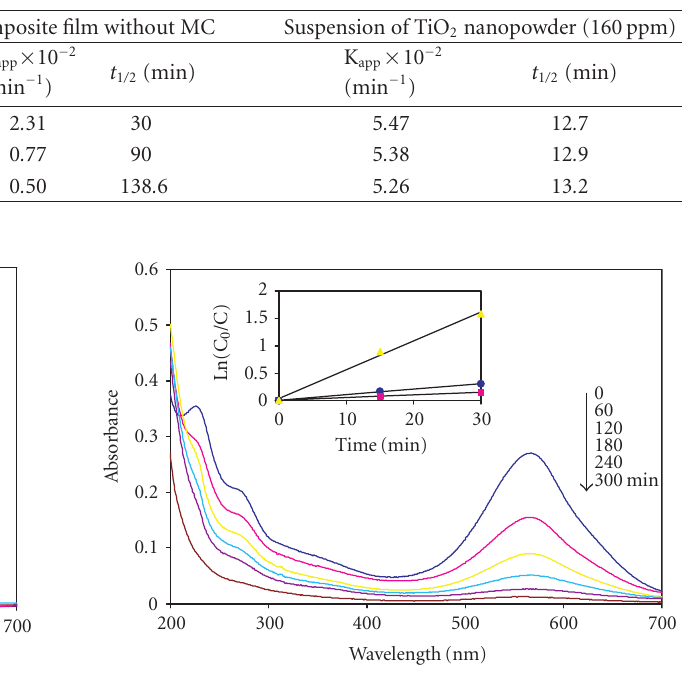
Figure 8: Time-dependent UV-Vis spectrum of Tertro direct light blue solution during photoirradation on one piece of composite TiO 2 with MC, pH 6.00, dye concentration, 10ppm. The inset of the figure shows the kinetic data for this dye in the presence of slurry nanopowder TiO 2 (160ppm) solution ( (cid:2) ), composite thick film without MC ( (cid:2) ), and composite thick film with MC ( •